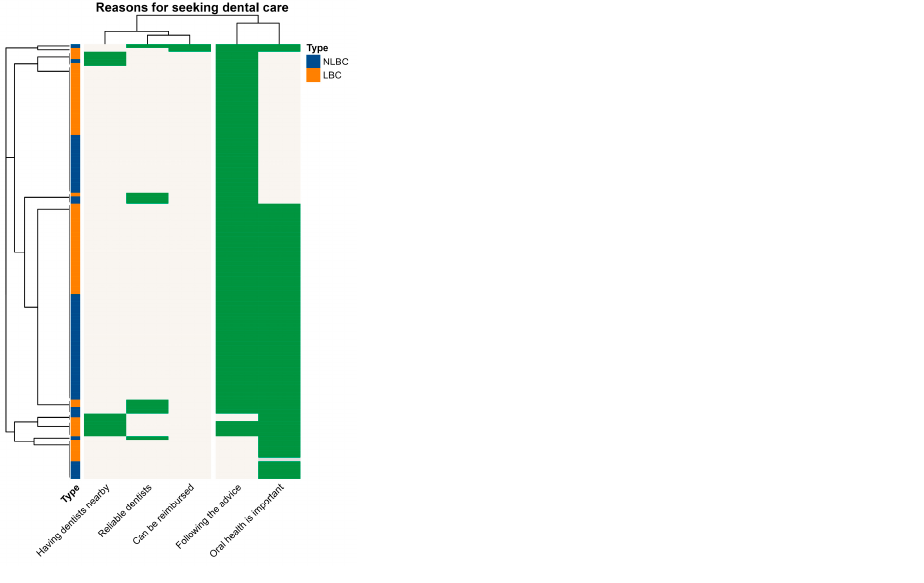
Figure 5. Heatmap showing clustering of reasons for seeking dental care among participates.